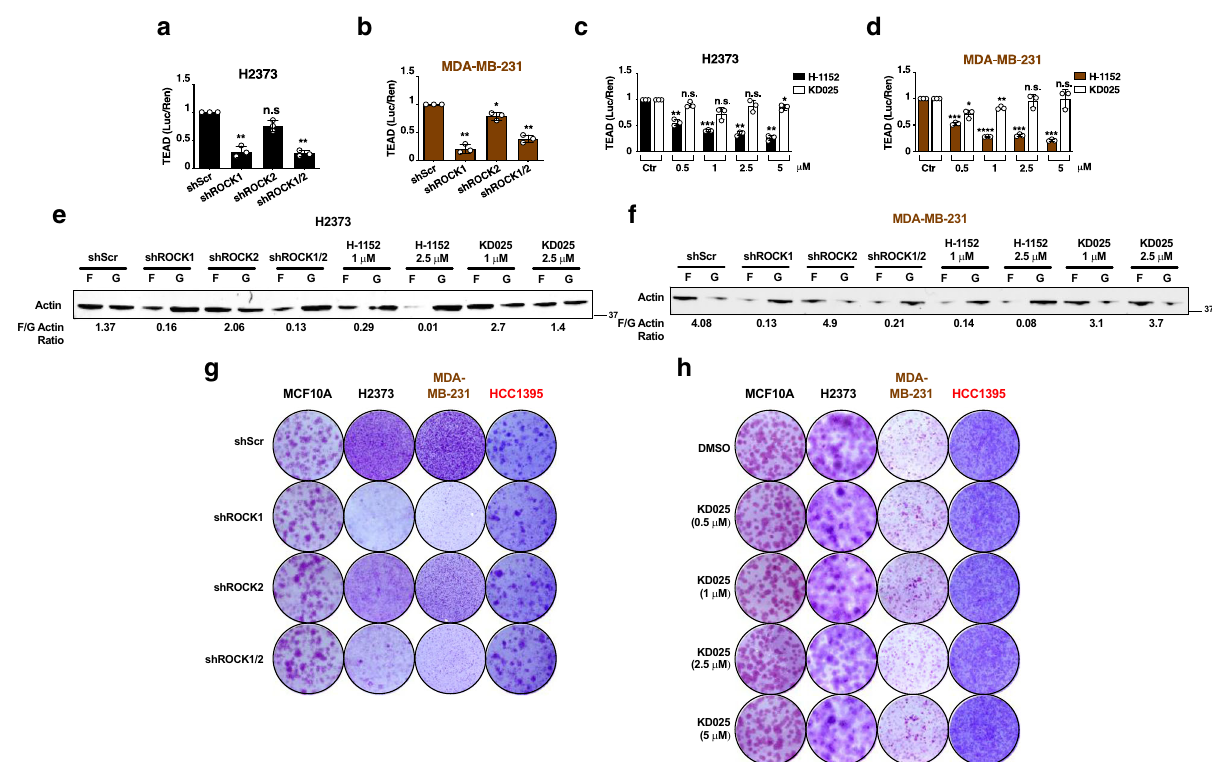
Fig. 4 ROCK1 signaling through the actin cytoskeleton is required for TEAD/YAP transcriptional activation and the transformed phenotype of human tumors with p53 DNA contact and/or Hippo pathway mutations. a , b TEAD reporter activity of H2373 cells ( a ) or MDA-MB-231 cells ( b ) stably expressing shScr, shROCK1, shROCK2 or shROCK1/2. c , d TEAD reporter activity of H2373 cells ( c ) or MDA-MB-231 cells ( d ) untreated or treated with increasing concentrations of the ROCK dual inhibitor, H-1152 or the ROCK2 speci fi c inhibitor, KD025 for 24 h. e , f Western blot analyses of Triton-insoluble (F-actin) and Triton-soluble (G-actin) fractions extracted from the indicated tumor cells stably expressing shScr, shROCK1, shROCK2, shROCK1/2 or treated with the indicated inhibitors for 24 h. Fractions were probed with β -actin antibody. Ratio between F- and G-actin is shown representative of n = 2 biologically independent replicates. g Representative plates from n = 2 biologically independent replicates showing 2D colony formation by the indicated cell lines stably expressing shScr, shROCK1, shROCK2, shROCK1/2 for 14 days. h Representative plates from n = 2 biologically independent replicates showing 2D colony formation by the indicated cell lines treated with DMSO or increasing concentrations of KD025 every 2 days for 14 days. p values were derived using two-tailed t -tests from means± SD of n = 3 independent experiments. * p < 0.05, ** p < 0.01, *** p < 0.001, **** p < 0.0001. Source data with actual calculated p values are provided as Source data fi fi ndings established that ROCK1/actomyosin signaling itself rather than differences at the level of ROCK RNA expression was the critical effector of oncogenic TEAD/YAP transcription in tumors with recurrent p53 DNA contact and/or Hippo pathway lesions.